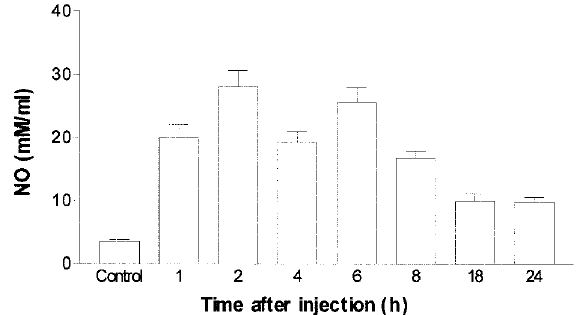
FIG. 4. NO production. Groups of female mice injected as described in the text. The levels of NO present in serum were determined as previously described. Each point represents the values of samples from two experiments ± SD in different groups of five to 15